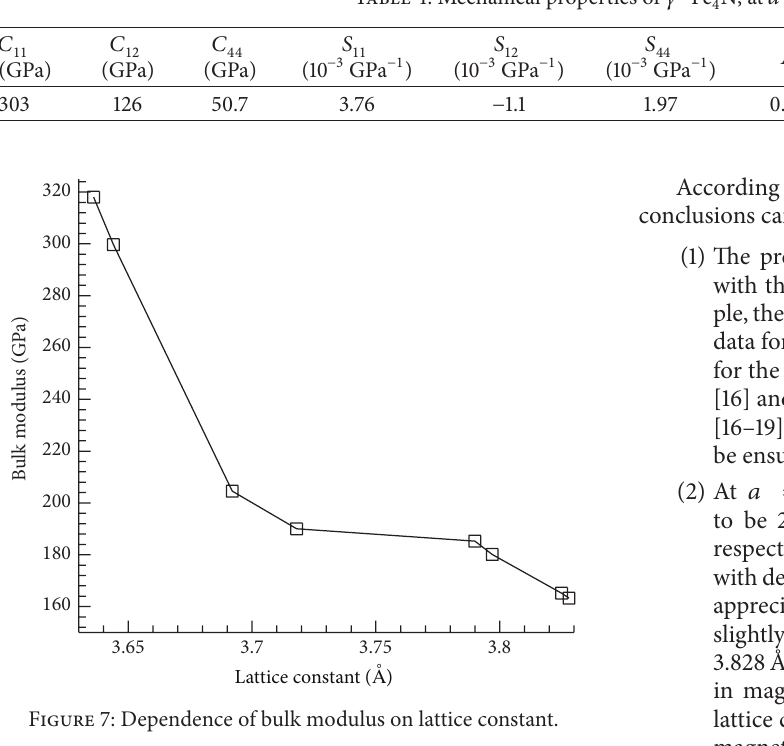
Table 4: Mechanical properties of 𝛾 󸀠 -Fe 4 N, at 𝑎 = 3.772 ˚A.